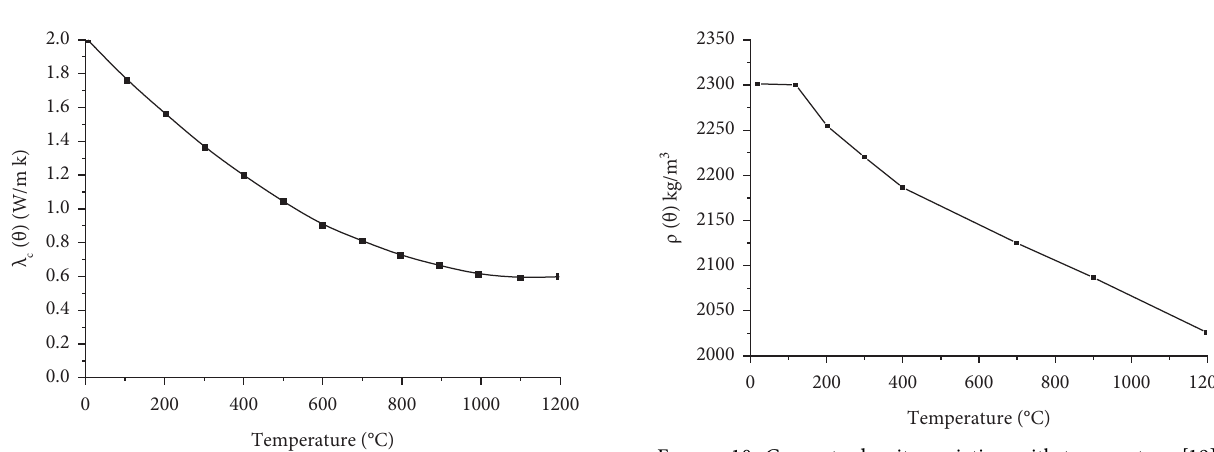
Figure 7: Concrete thermal conductivity [19].